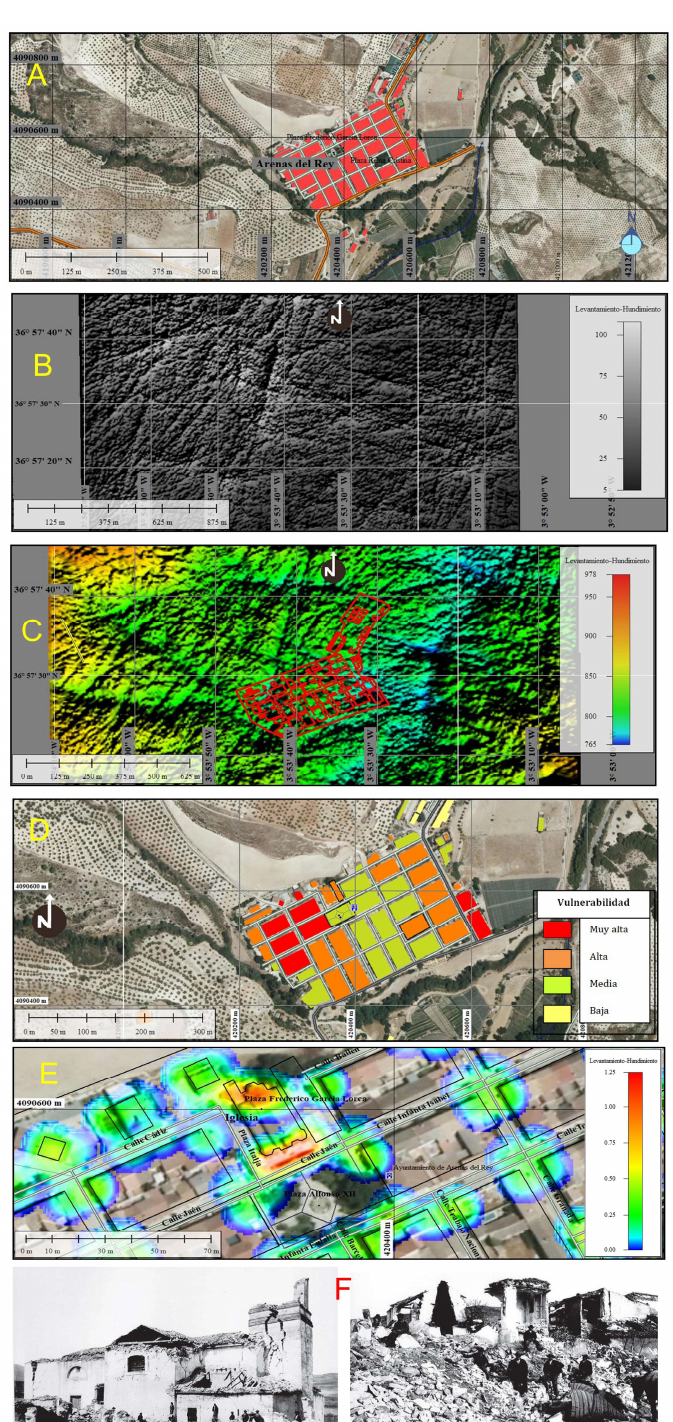
Figure 9. ( A ) Location of Zone 3 in Arenas del Rey, Granada, Andalusia, Spain. ( B ) Structural lineaments of the study area. ( C ) Positioning of the city outline on relief structural lineaments. ( D ) Vulnerability intensity by relief deformation in the city outline. ( E ) Punctual deformation in the Federico Garcia Lorca Church to Jaen Street. ( F ) Images of the 6.2 to 6.5 in the Richter scale earthquake in 1884.